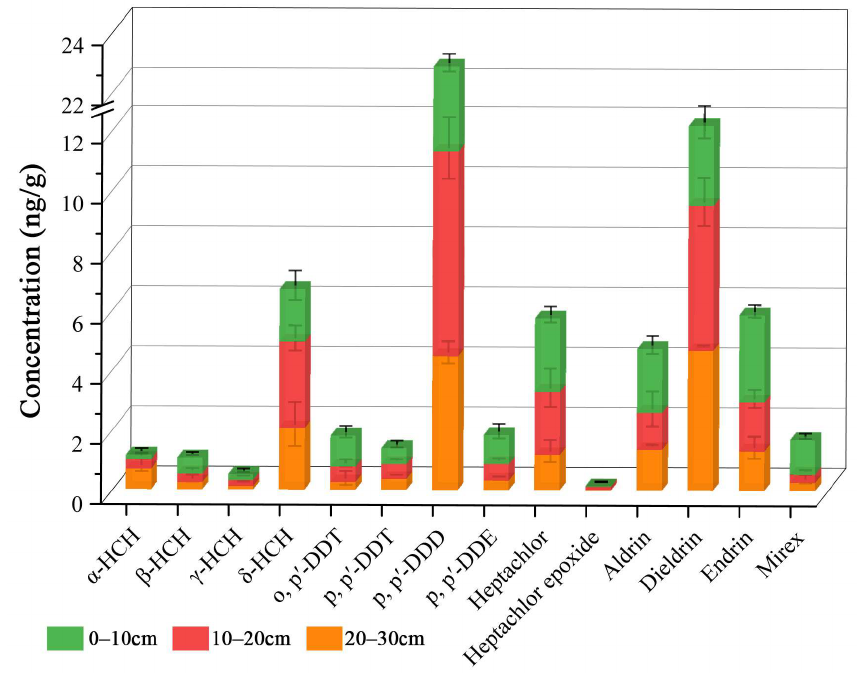
Figure 1. Vertical distribution concentration of 14 organochlorine pesticides.